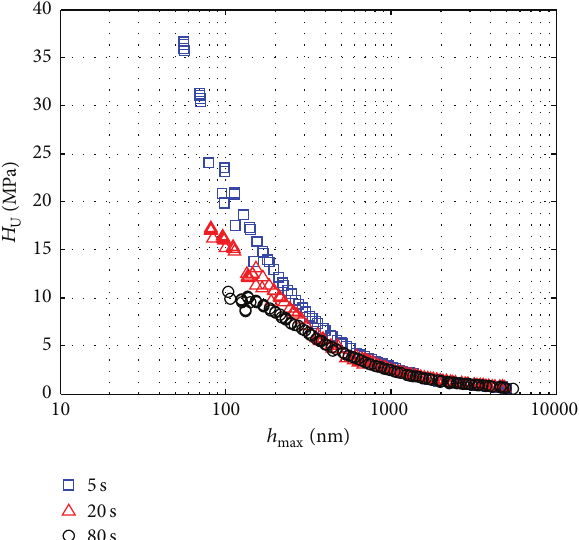
Figure 25: Universal hardness of PDMS determined by a Berkovich tip with different loading times of 5, 20, and 80 s [33].